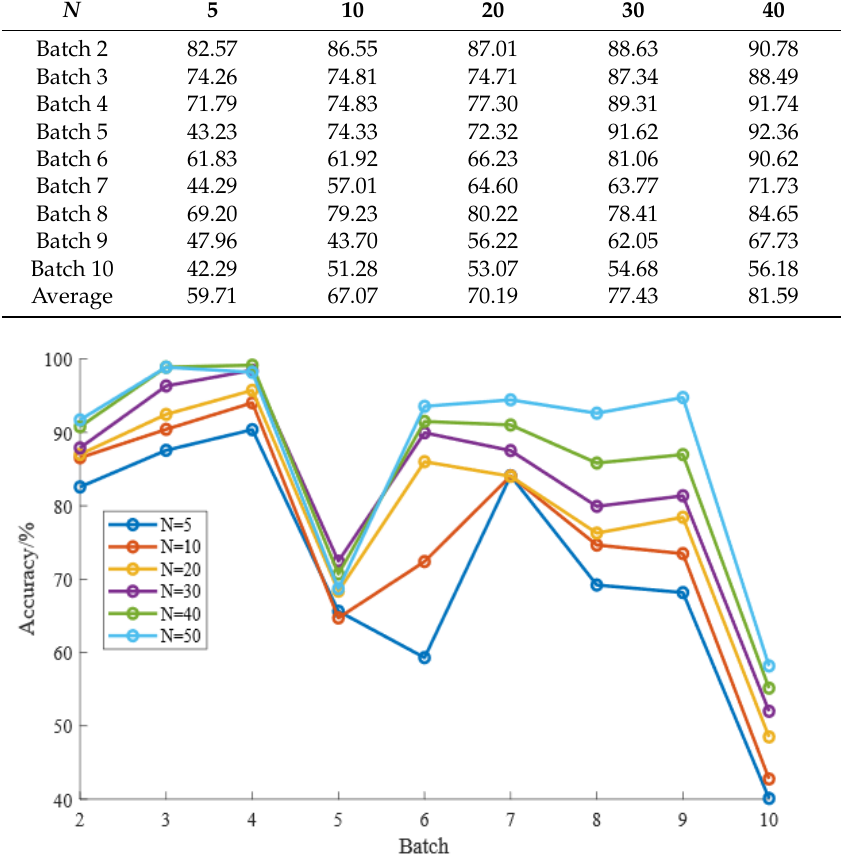
Figure 5. Effect of 𝑁 on short-term drift